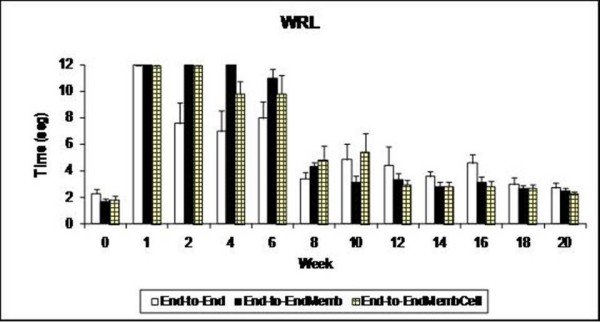
Weekly values of the withdrawal reflex latency test. At week-1 all animals failed in responding to the noxious thermal stimulus within the 12 sec cut-off time. No differences between the percentages of motor deficit obtained by the Extensor Postural Thrust (EPT) test. * Significantly different from week-0 all groups pooled together (p < 0.05). Results are presented as mean and standard error of the mean (SEM).